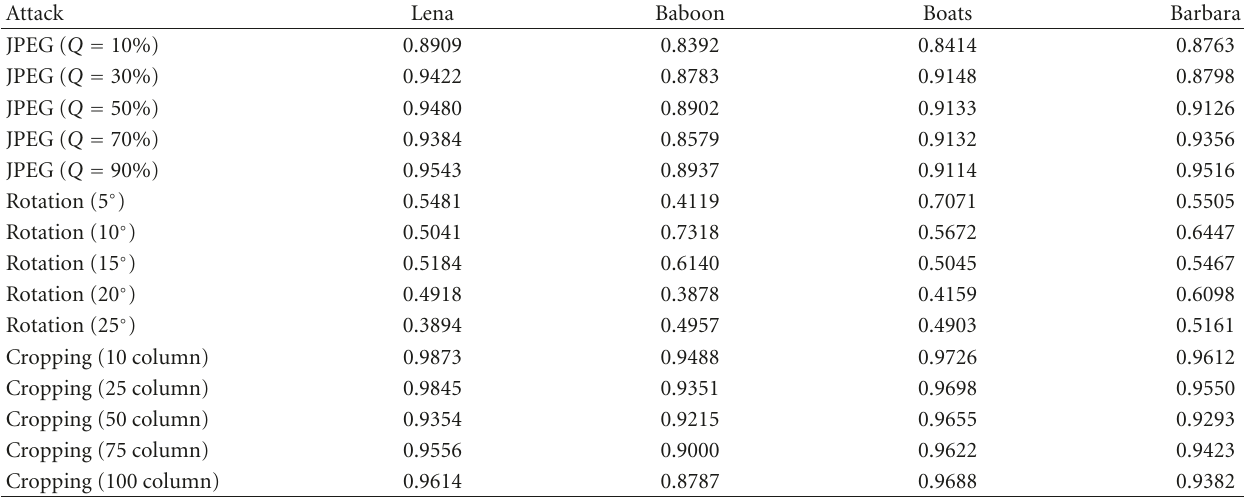
Table 3: Correlations between the original and the extracted watermarks under di ff erent attacks.